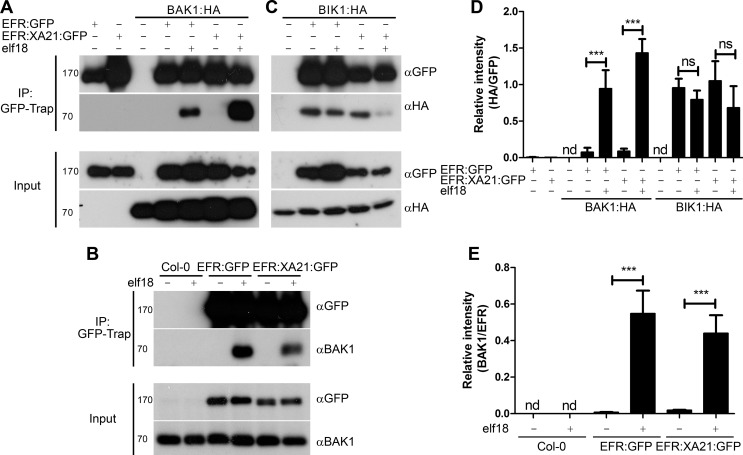
Dynamic association of EFR and the EFR:XA21 chimera with BAK1 and BIK1 in planta.A. Co-immunoprecipitation of transiently-expressed EFR:GFP and EFR:XA21:GFP with BAK1:HA in N. benthamiana. Leaves were treated with 100 nM elf18 (+) or mock treated with water (−) for 10 min. Immunoprecipitation (IP) was performed with GFP-Trap agarose beads. Western blots were performed with HRP-conjugated anti-GFP and anti-HA antibodies. Experiments were performed at least twice with similar results. B. Co-immunoprecipitation with BAK1 in A. thaliana Col-0 and efr-1 transgenic homozygous lines stably expressing EFR:GFP or EFR:XA21:GFP under the control of the 35S promoter. Leaves were treated with 100 nM elf18 (+) or mock treated with water (−) for 10 min. Immunoprecipitation (IP) was performed with GFP-Trap agarose beads. Western blots were performed with HRP-conjugated anti-GFP, anti-HA or anti-BAK1 antibodies. Experiments were performed at least twice with similar results. C. Co-immunoprecipitation of transiently-expressed EFR:GFP and EFR:XA21:GFP with BIK1:HA in N. benthamiana. Leaves were treated with 100 nM elf18 (+) or mock treated with water (−) for 10 min. Immunoprecipitation (IP) was performed with GFP-Trap agarose beads. Western blots were performed with HRP-conjugated anti-GFP and anti-HA antibodies. Experiments were performed at least twice with similar results. D, E. Quantitation of data presented in A and C. Values are the average ratio of BAK:HA or BIK:HA to EFR:GFP ±SE (n = 3). Asterisks indicate statistical significance of mock compared to elf18 treated, p < 0.001 (Student’s t-test). ns is not significant at p <0.05. nd is not determined.